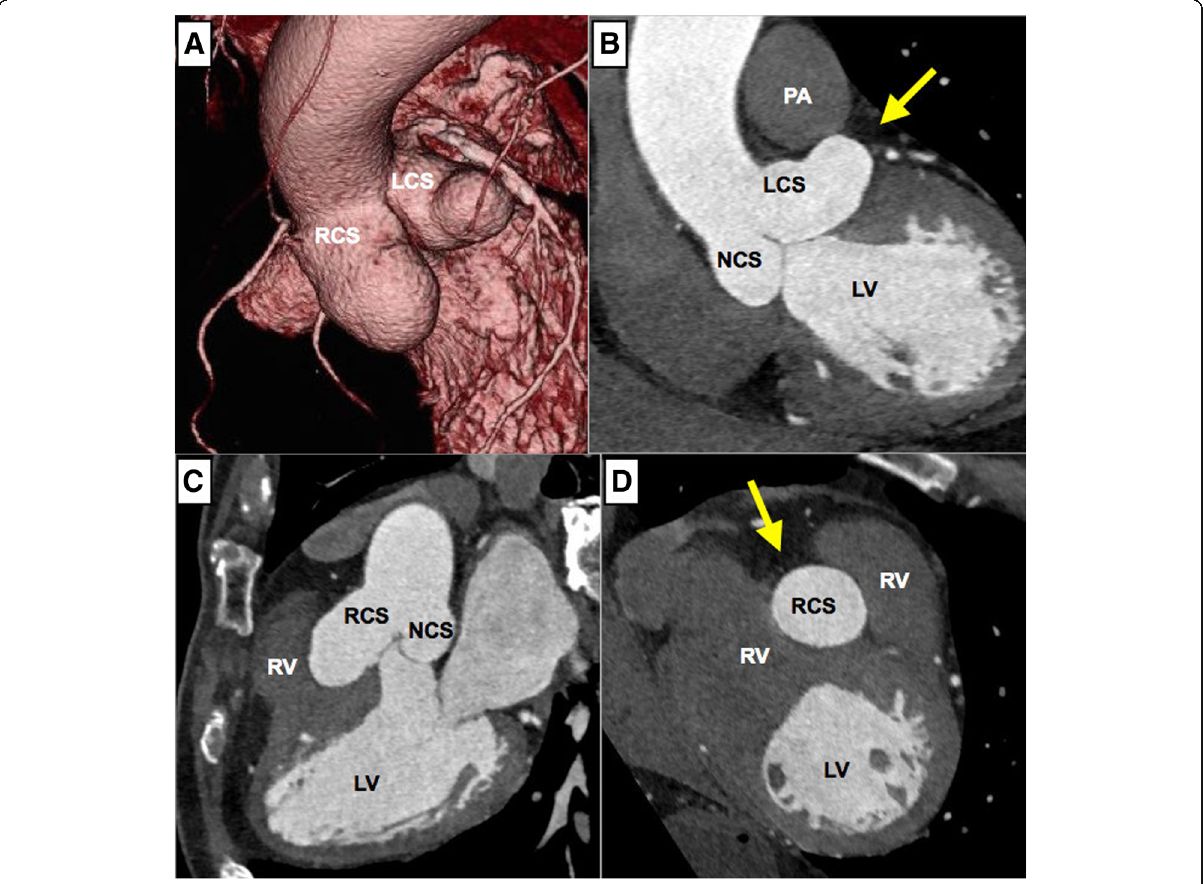
Fig. 1 Three-dimensional ( a ) and multiplanar ( b – d ) reconstruction by electrocardiogram-gated cardiac computed tomography showing extracardiac aneurysms in the left and the right coronary sinuses. Those aneurysms press aside the pulmonary artery and the right ventricle and bulge out on the surface of the heart (arrows). LCS, left coronary sinus; RCS, right coronary sinus; NCS, noncoronary sinus; LV, left ventricle; RV, right ventricle; PA, pulmonary